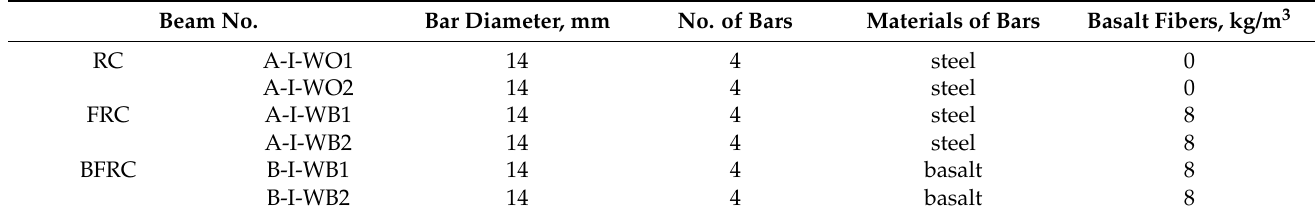
Table 1. Beam designation and reinforcement parameters of BFRP RC beams. Beam